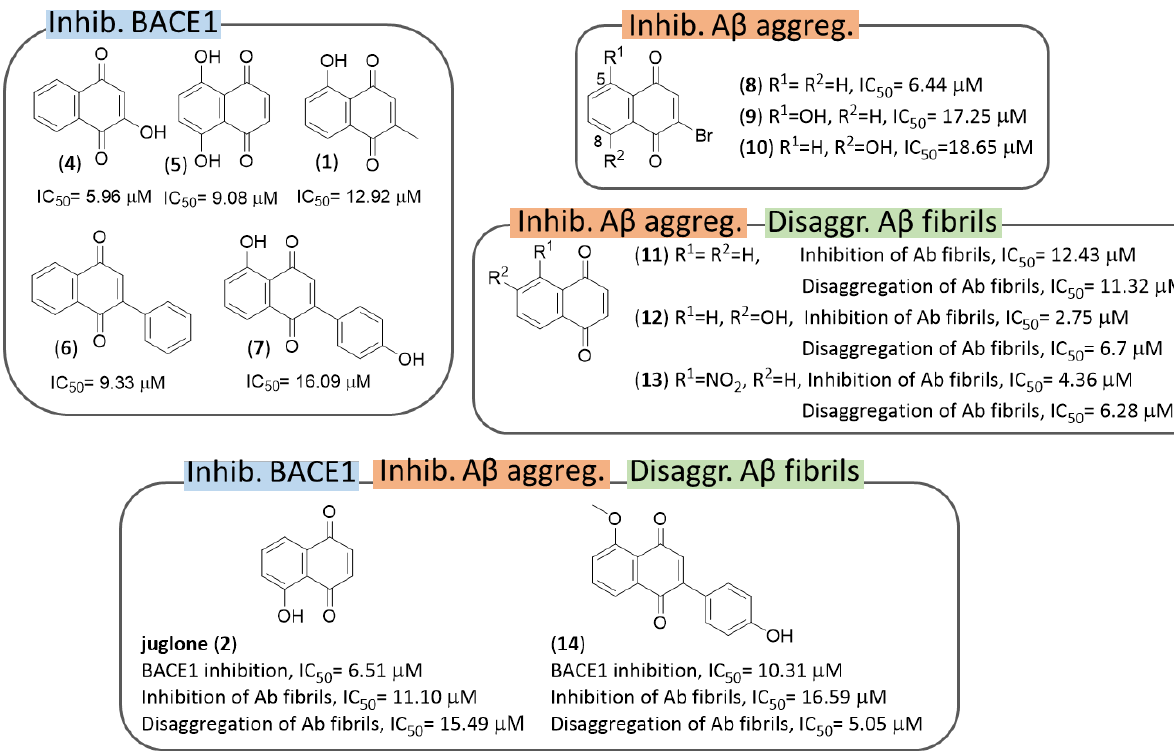
Figure 5. Anti-amyloidogenic properties of NQs investigated by P. Bermejo-Bescós et